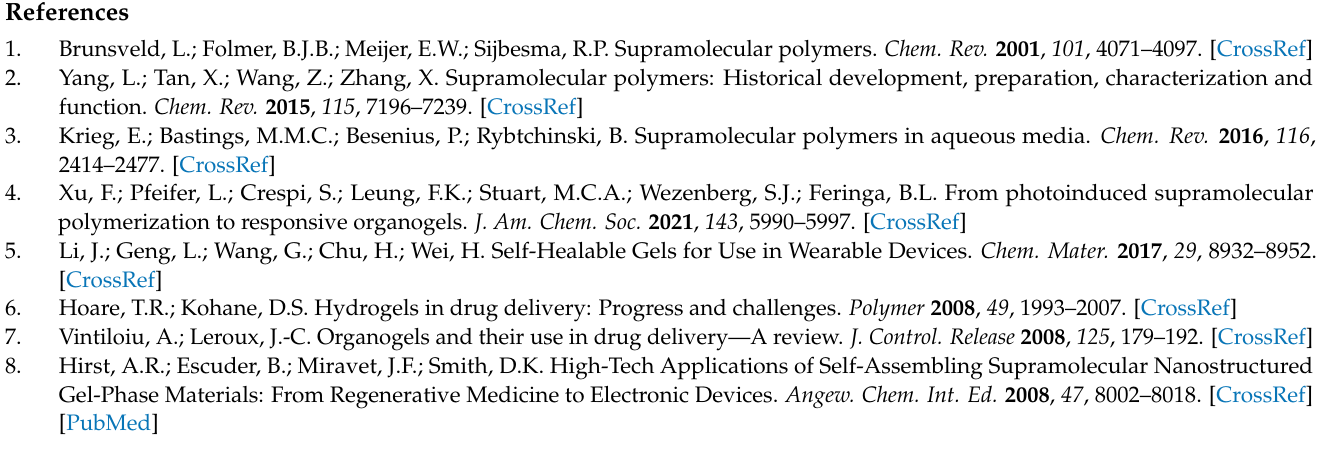
der crystal structure of NDI 1 showing face-to-face π – π interactions between the central naphthalene diimide moieties, Figure S2: Crystal structure of NDI 2 showing absence of π - π stacking interaction, Figure S3: Packing diagram of NDI 2 along crystallographic b and c direction, Figure S4: The supramolec- ular gel in DMF exhibit reversible sol to gel transitions induced by temperature at 66 ◦ C, Figure S5: POM image of β -CD in DMF, Figure S6: Self healing property of NDI 1 and β -CD in DMF gel by POM images, Figure S7: The schematic representation of the supramolecular polymer and gel formation, Figure S8: 1 H NMR (400 MHz, CDCl3, δ in ppm, 298 K) spectrum of NDI 1 , Figure S9: 13 C NMR (100 MHz, CDCl3, δ in ppm, 298 K) spectrum of NDI 1 , Figure S10: Mass spectrum of NDI 1 , Figure S11: FT-IR spectrum of NDI 1 , Figure S12: 1 H NMR (500 MHz, DMSO-d6, δ in ppm, 298 K) spectrum of NDI 2 , Figure S13: 13 C NMR (125 MHz, DMSO-d6, δ in ppm, 298 K) spectrum of NDI 2 , Figure S14: Mass spectrum of NDI 2 , Figure S15: FT-IR spectrum of NDI 2